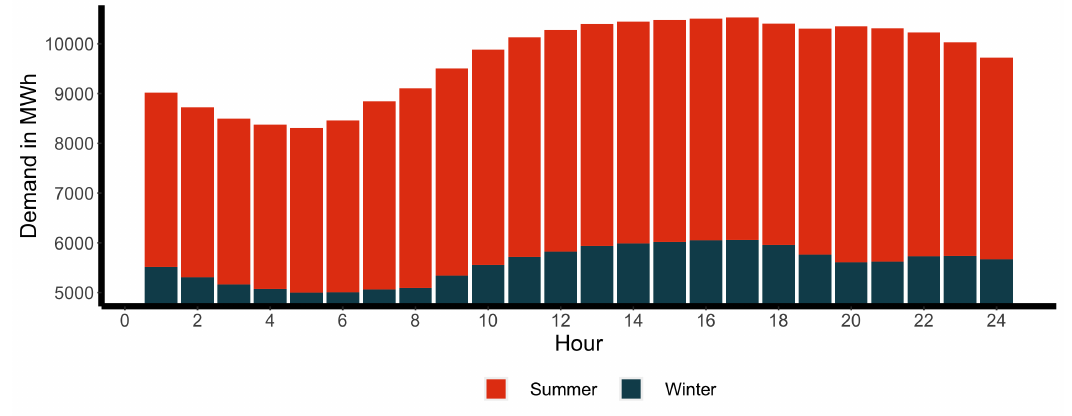
Figure 3. Load profile of the Mexican electric